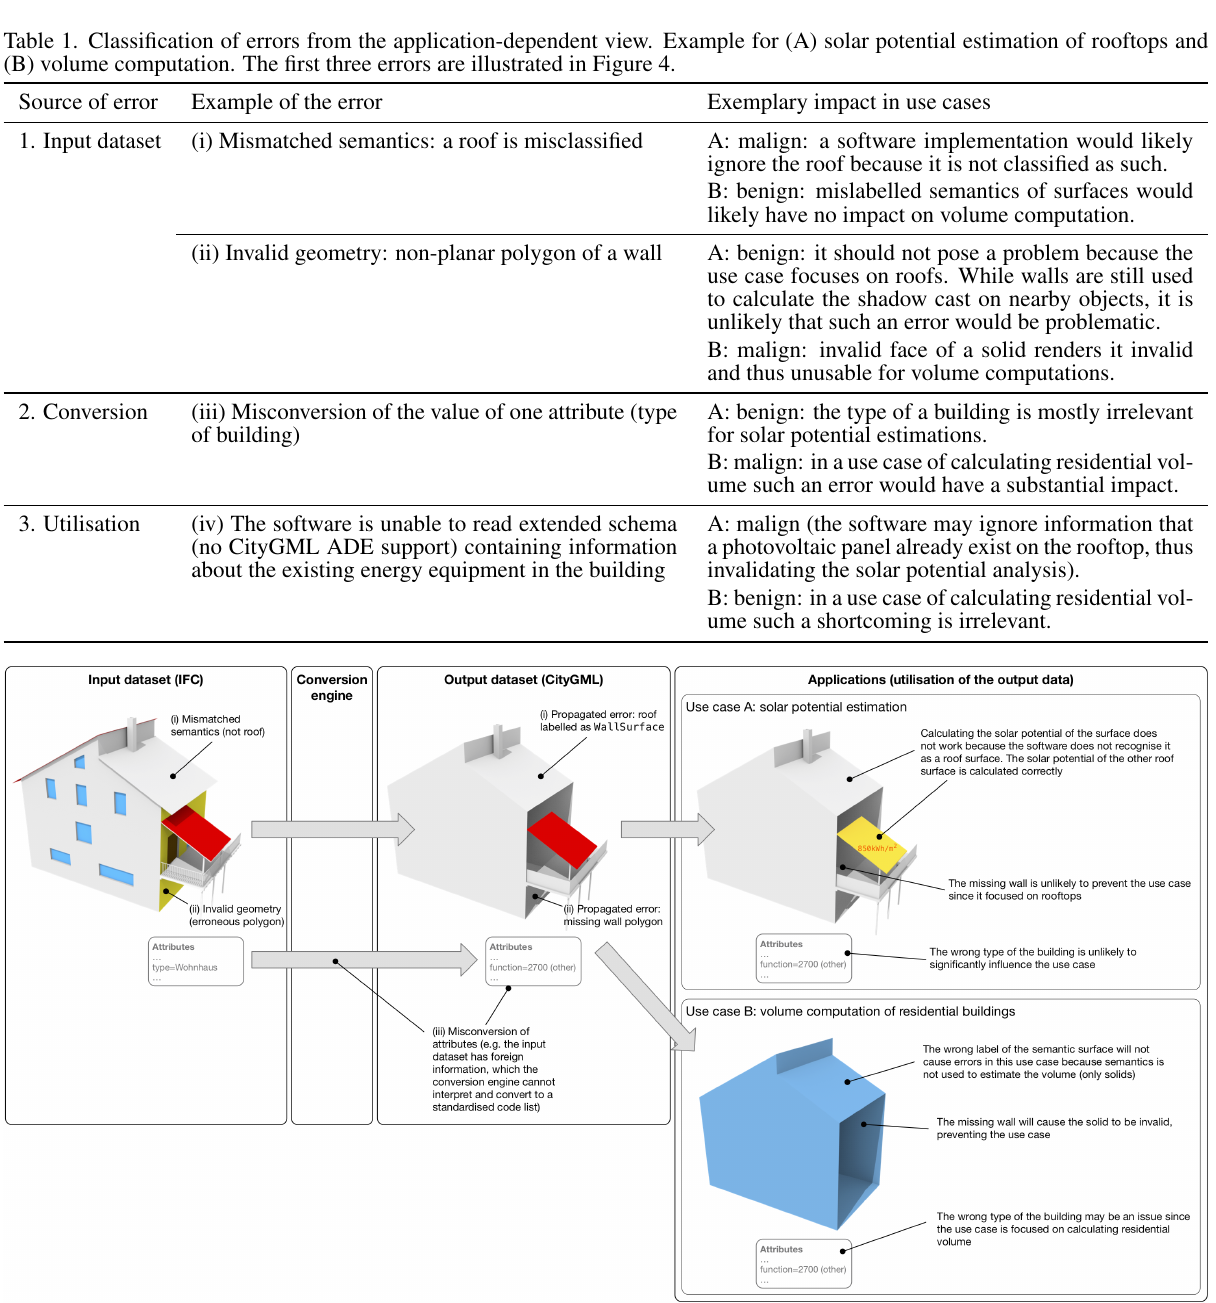
Figure 4. Combination of different types of errors results in multiple categories that are depending on the use case context. These errors are further described in Table 1. Source of the dataset (with modifications) used to generate the illustration: Institute for Applied Computer Science, Karlsruhe Institute of Technology (H¨afele,